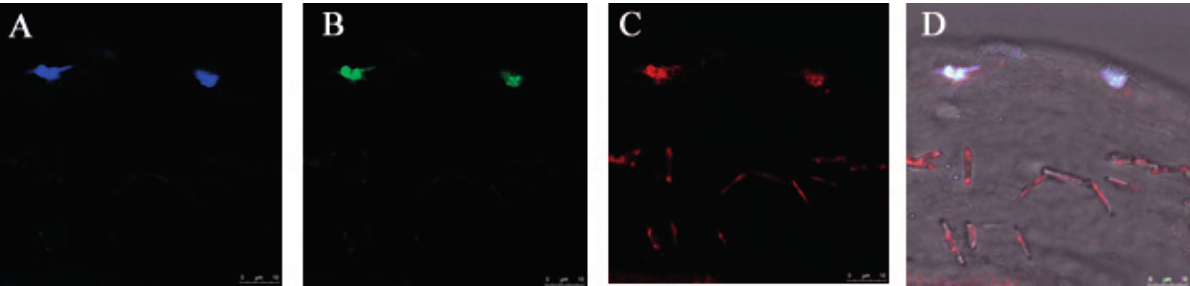
Figure 7. The histological observation of cyclo -( D -Trp-Tyr) peptide nanotubes (PNTs) with the TM-rhodamine-labeled plasmid CAP3 pRFP-C-RS distribution in tissues of nude mice after 8 h of eye drop delivery with thioflavin T (ThT) pre-stained PNTs. DAPI image (blue) ( A ), ThT image (green) ( B ), rhodamine image (red) ( C ) merged with the bright field image ( D ). Note that the small ThT pre-stained PNTs (green color) and rhodamine-labeled plasmid (red) were co-located in the stoma area of cornea. Scale bars denote 10 μ m.